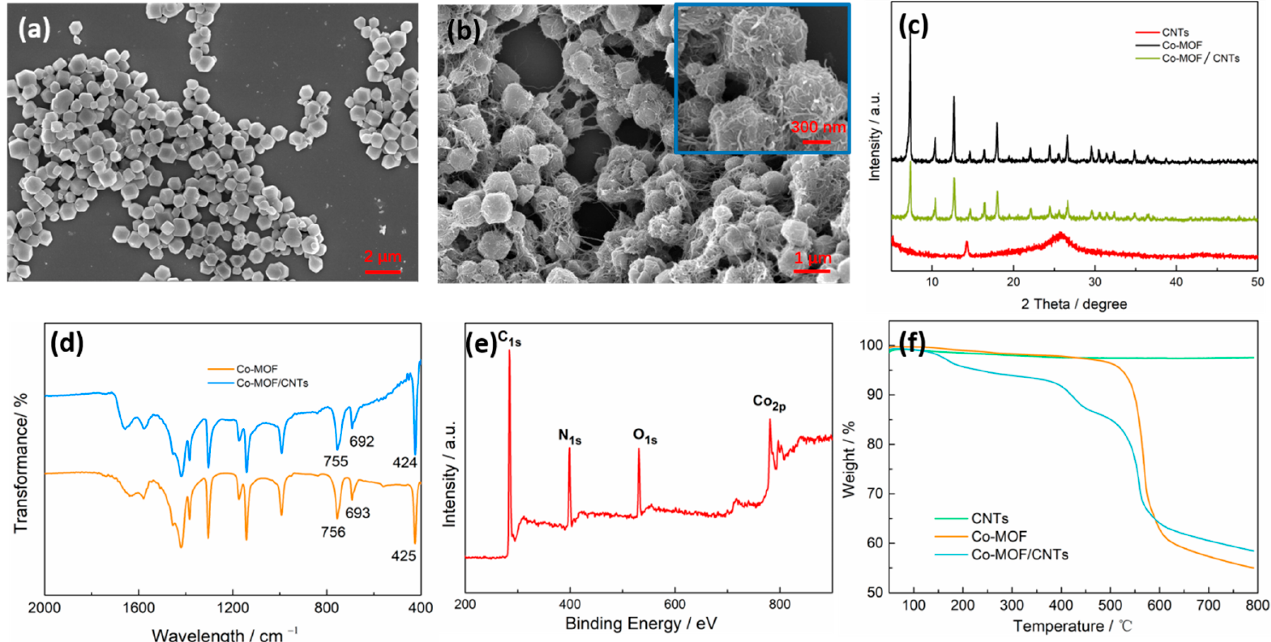
Figure 2. FE-SEM images of Co-MOF ( a ) and Co-MOF/CNTs ( b ); XRD pattern of CNTs, Co-MOF and Co-MOF/CNTs ( c ); FTIR spectrum of Co-MOF and Co-MOF/CNTs ( d ); XPS spectrum of Co- MOF/CNTs ( e ); TGA results of CNTs, Co-MOF and Co-MOF/CNTs ( f ).